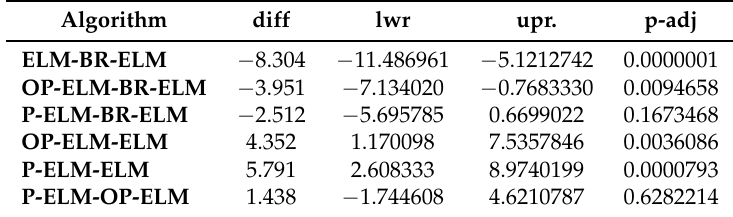
Table 9. Tukey multiple comparisons of means. 95% family-wise confidence level.